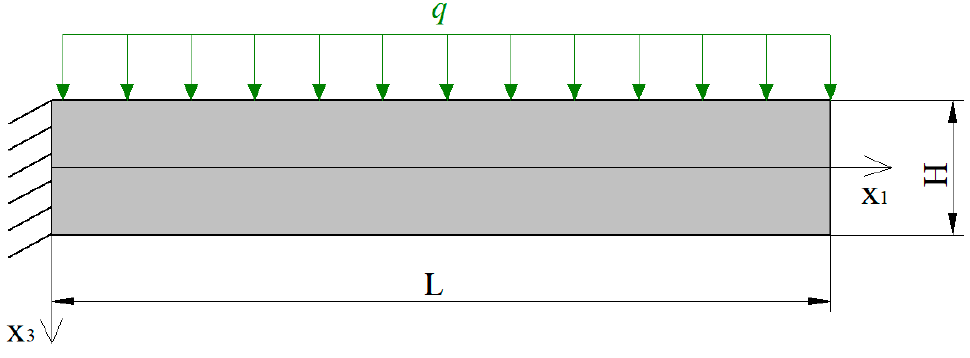
Figure 1. Cantilever beam under the transverse force load.